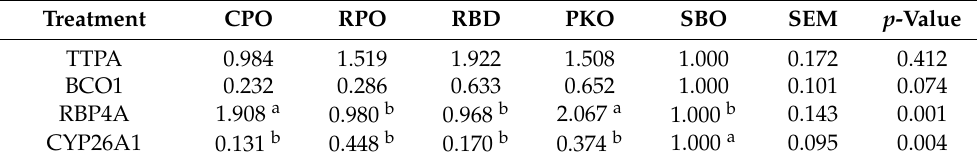
Table 8. Liver retinol, β -carotene and tocopherol gene expression in laying hens fed different oils. Treatment CPO